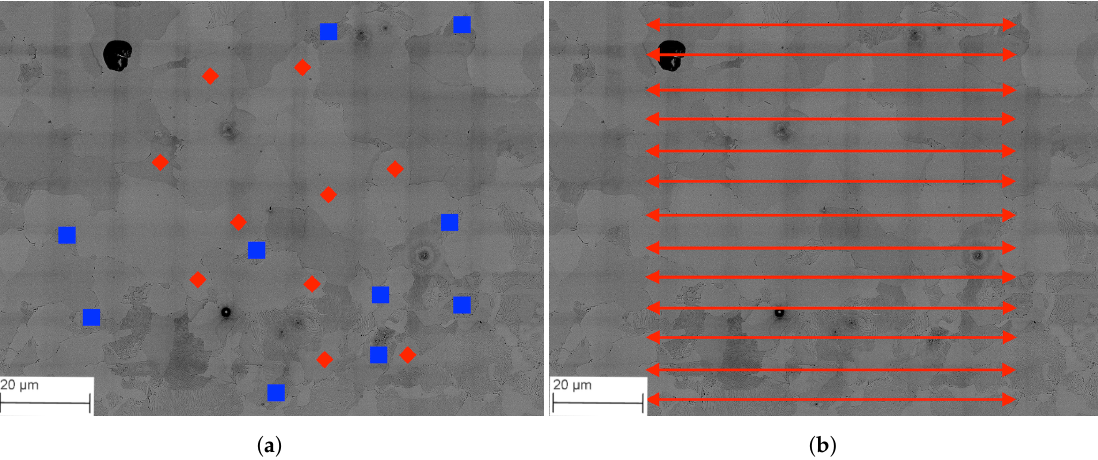
Figure 15. ( a ) Grains used for local strain measurements in Figure 14, where the blue squares are pearlite grains and the red diamonds are ferrite grains. ( b ) Vectors used as virtual extensometer for the average engineering strain over the recorded area, having an initial length of 80